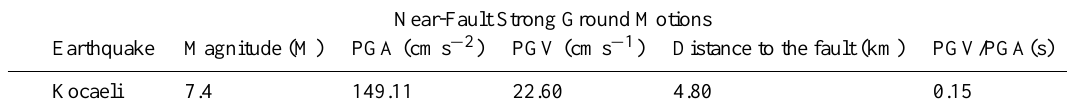
Table 2. Properties of a selected near-fault earthquake ground motion record.